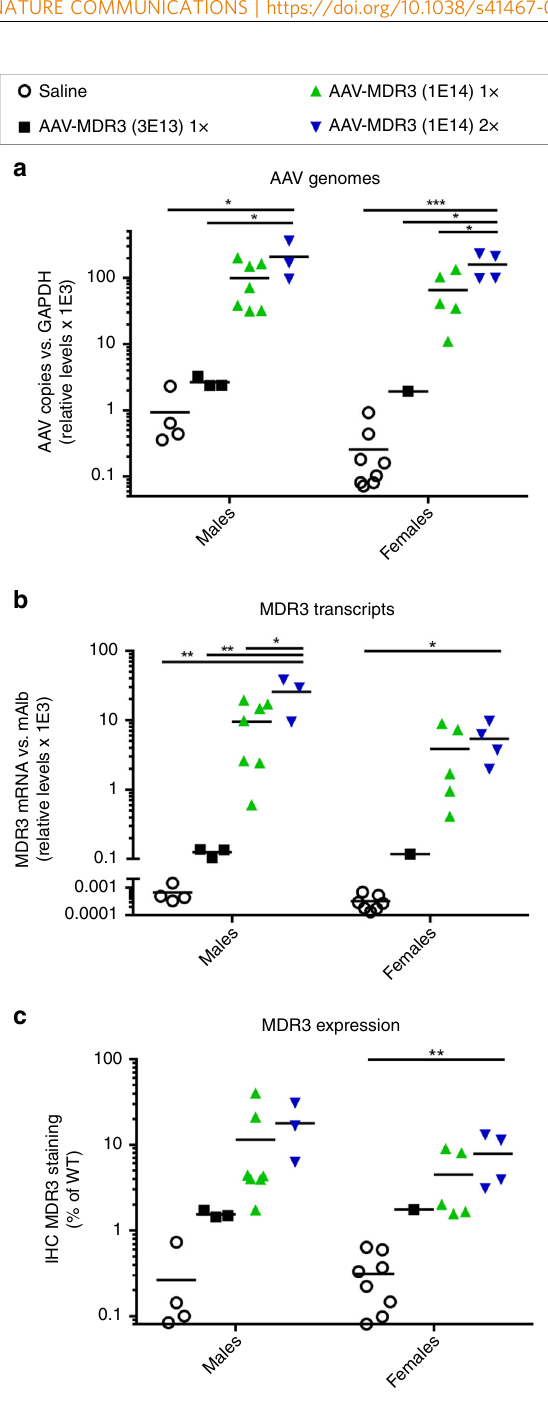
Fig. 5 AAV transduction and transgene expression for Abcb4 − / − mice treated with AAV-MDR3-Aco. The levels of AAV genomes ( a ), MDR3 mRNA transcripts ( b ), and MDR3 protein expression ( c ) were quanti fi ed from liver tissue harvested from Abcb4 − / − mice treated with AAV-MDR3- Aco at 3 × 10 13 VG/kg 1× (black squares), at 1 × 10 14 VG/kg 1× (green triangles), or at 1 × 10 14 VG/kg 2× (blue inverted triangles), as well as saline-treated controls (open circles). AAV genomes and MDR3 transcripts were quanti fi ed via qPCR and RT-qPCR, respectively, and protein expression was quanti fi ed as the percent area of tissue that stained positive for MDR3 expression and normalized to levels in WT mice. Animals were sacri fi ced between 12 and 16 weeks after treatment. Statistics (one-way ANOVA/Tukey ’ s multiple comparisons test): *, p < 0.05; **, p < 0.01; ***, p < 0.001; data are presented as mean ± SD; F values and degrees